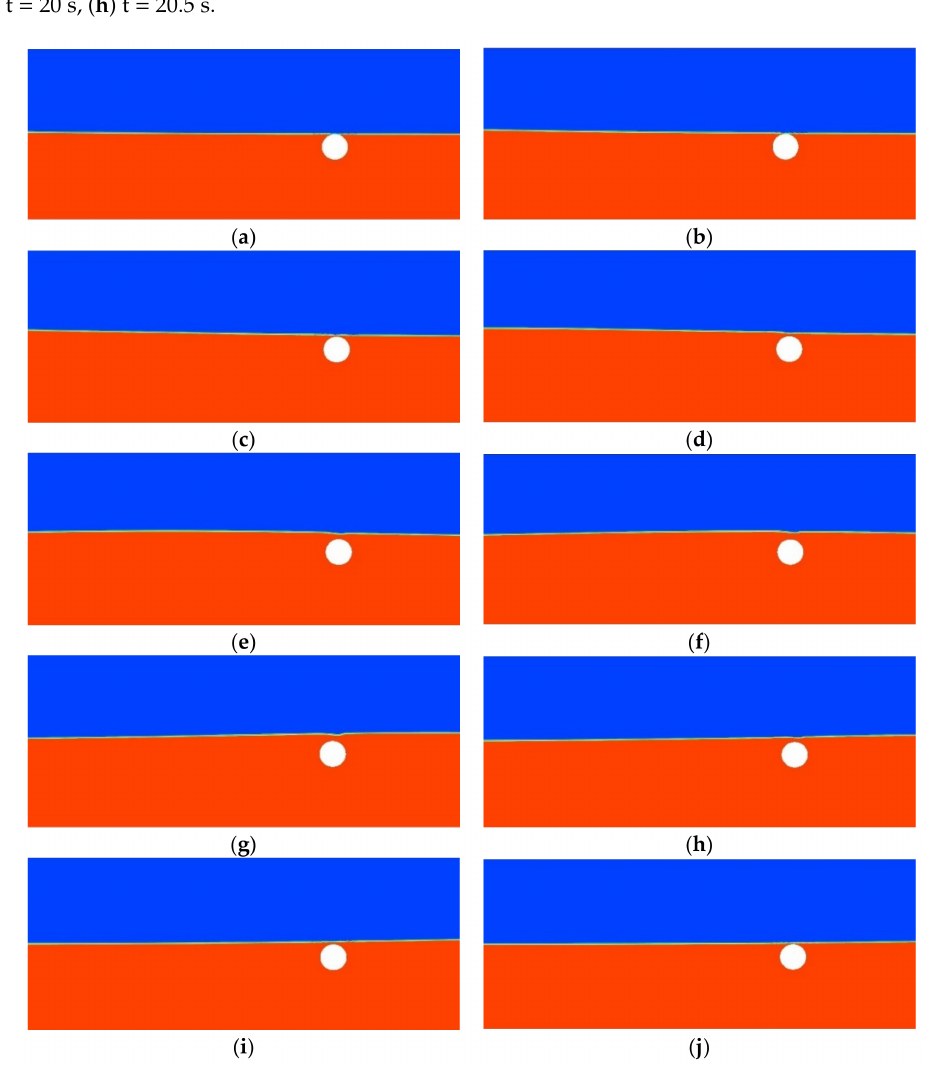
Figure 26. Snapshot of the evolution process of a solitary wave interacting with the unmoved cylinder for model 4. ( a ) t = 16.5 s, ( b ) t = 17 s, ( c ) t = 17.5 s, ( d ) t = 18 s, ( e ) t = 18.5 s, ( f ) t = 19 s, ( g ) t = 19.5 s, ( h ) t = 20 s, ( i ) t = 20.5 s, ( j ) t = 21